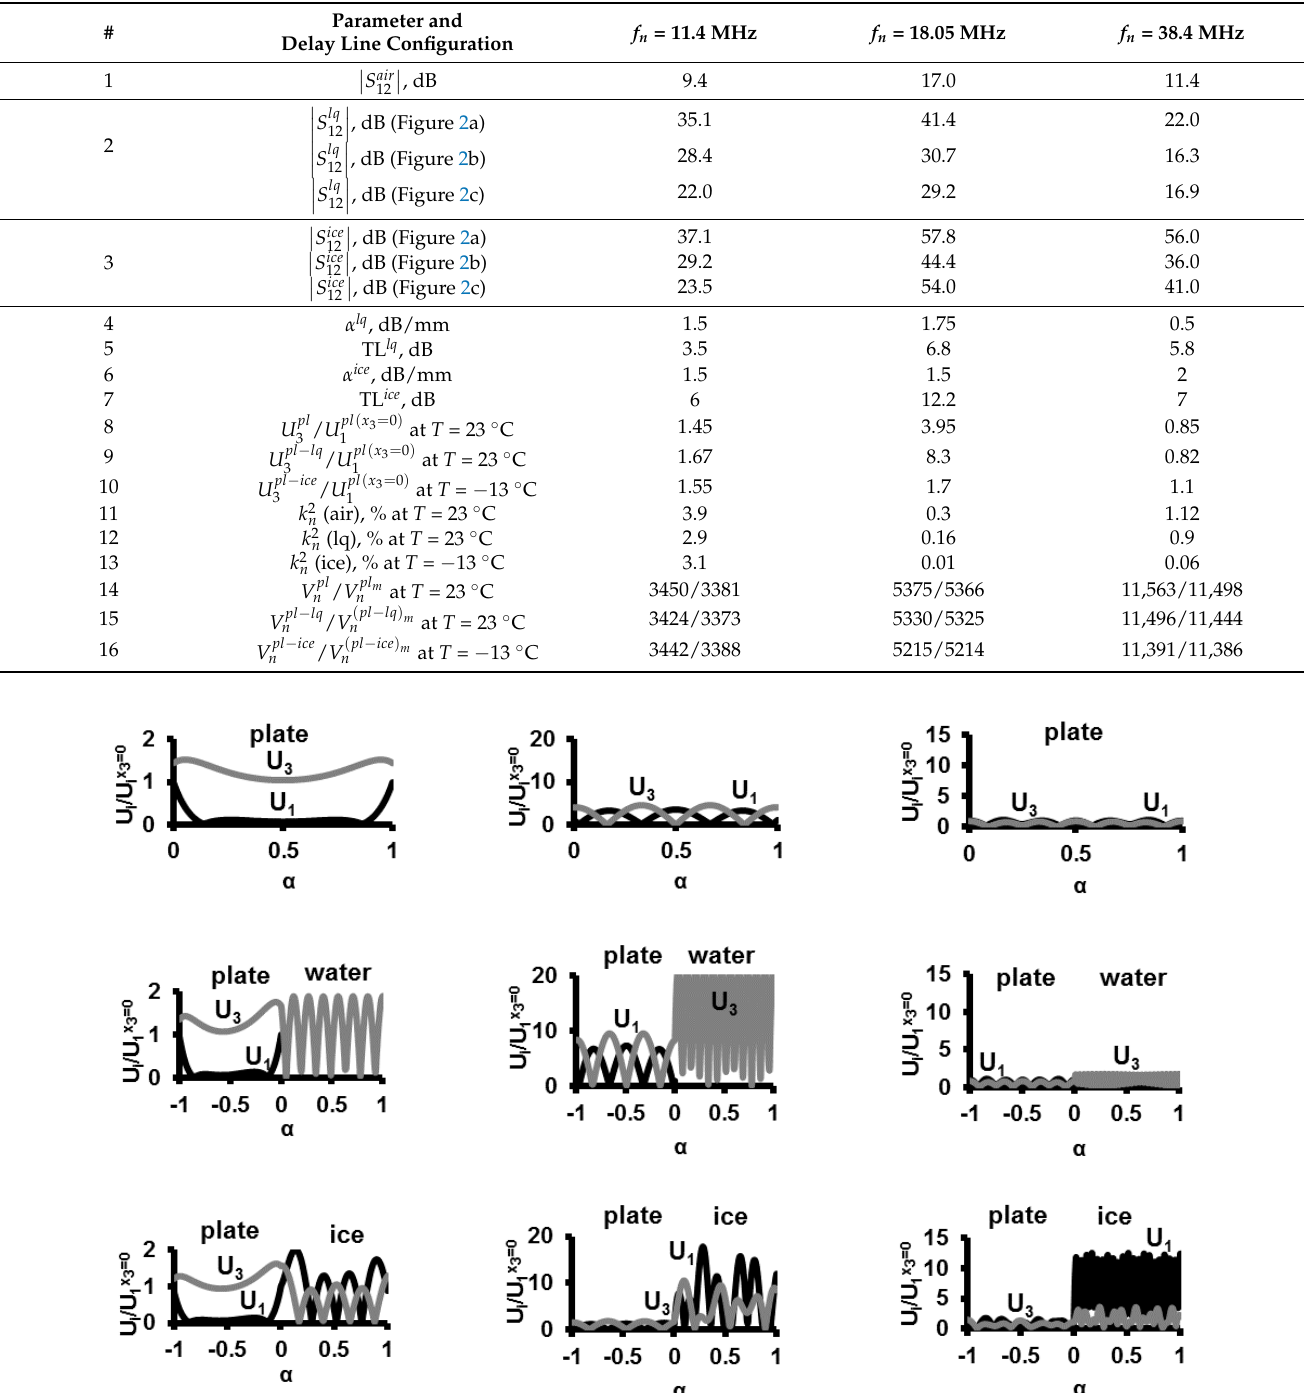
Table 2. Comparison of the estimations deduced from Equations (1)–(6) with the mode properties calculated numerically. Normalized thickness of the Y,Z-LiNbO 3 plate, water layer, and ice layer are h / λ = 1.67.